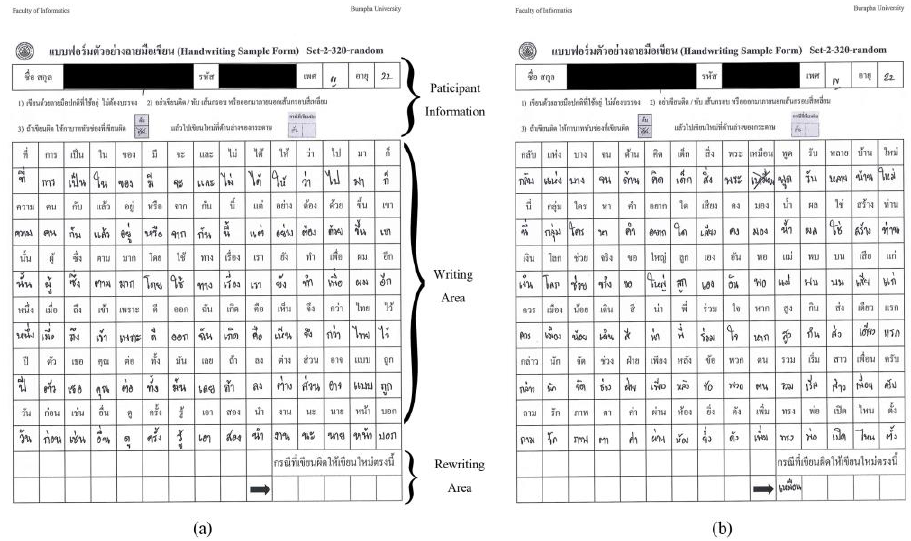
Figure 4. Data Collection Sheets: ( a ) depicts three parts of collected information ( b ) depicts the case of recording the characters, vowels, and digits and the case of rewriting any incorrect writing.